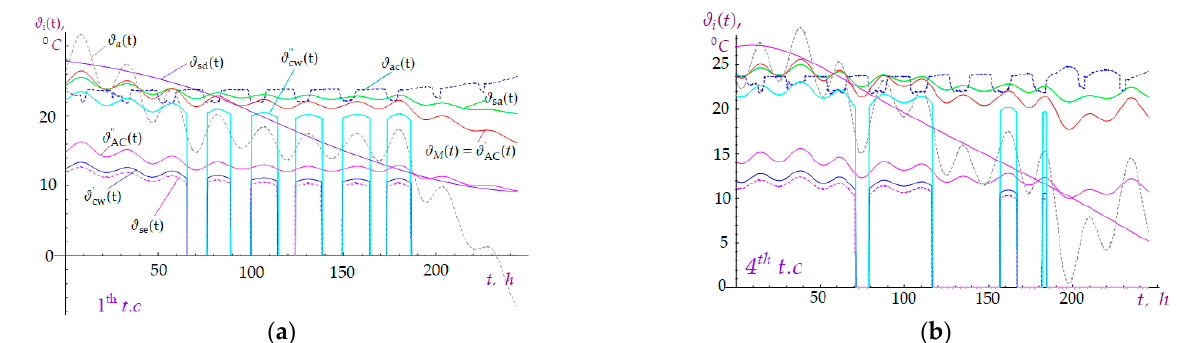
Figure 16. The characteristics of quasi-static balanced temperatures of involved process’s media in the ship’s accommodation climatization system; ( a ) for 1st transport cycle and ( b ) for the 4th transport cycle.